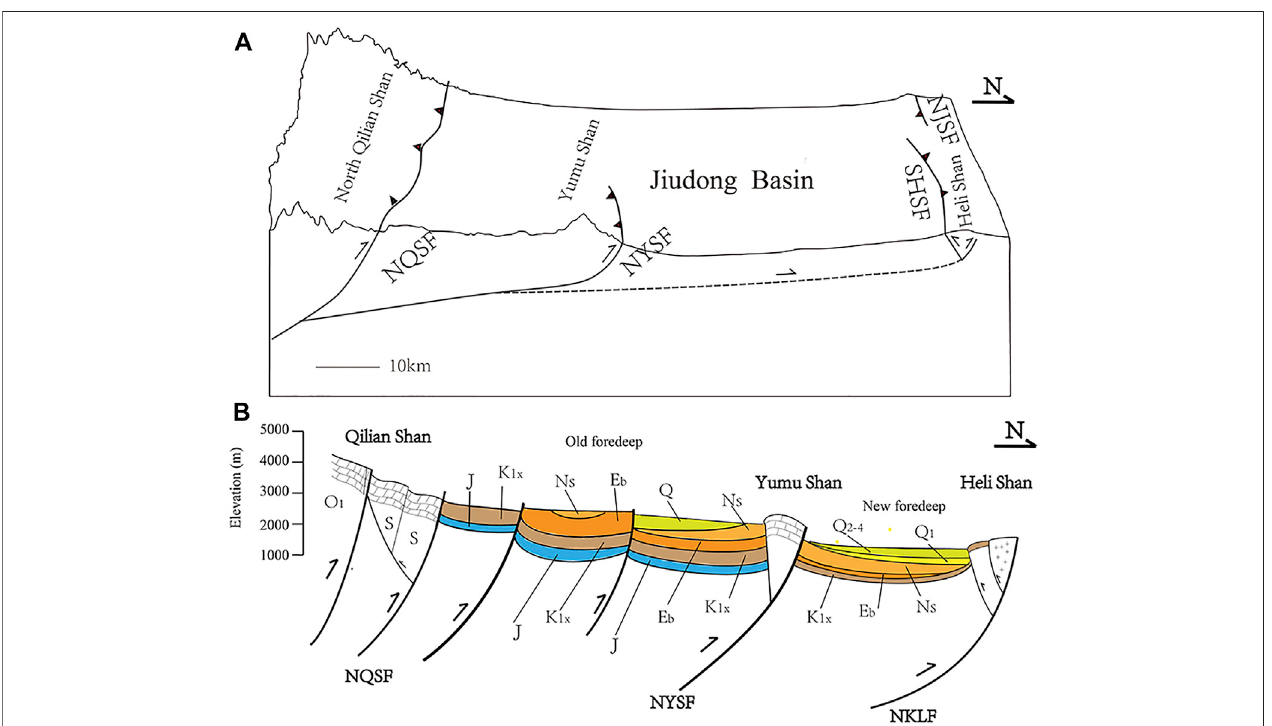
FIGURE2| Observations nearstudypro fi le. (A) Structure diagramoffourmajorthrustsand threemountain rangesinacrustal-scale SWS-NEN sectioninJiudong Basin (modi fi ed from Hu et al., 2019). These structural elements are now clearly associated with horizontal contraction dynamics in region. (B) Geological cross-section ofJiudongbasinonanearbypro fi le,closetoourselectedpro fi le;panelmodi fi edfromFangetal.,2012.NQSF,NorthQilianshanfault;NYSF,northYumuShanfault;and NKLF, northern marginal fault of Kuantan Shan – Longshou Shan. O 1 , Early Ordovician; S, Silurian; J, Jurassic; K 1x , Early Cretaceous Xiagou Formation; E b , Palaeogene Baiyanghe Formation; N s , Neogene Shulehe Formation; Q 1 , Early Quaternary; Q 2 – 4 , Late